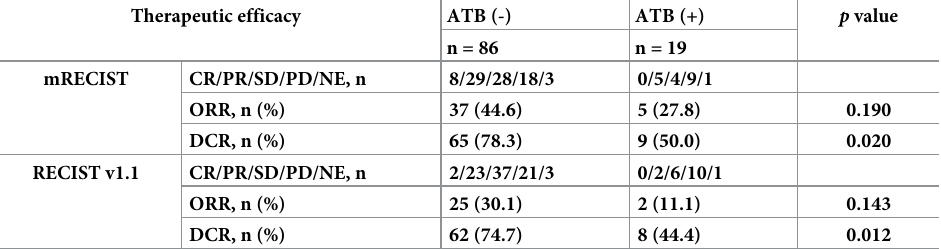
Table 2. Comparisons of therapeutic efficacy between the ATB (-) and ATB (+)